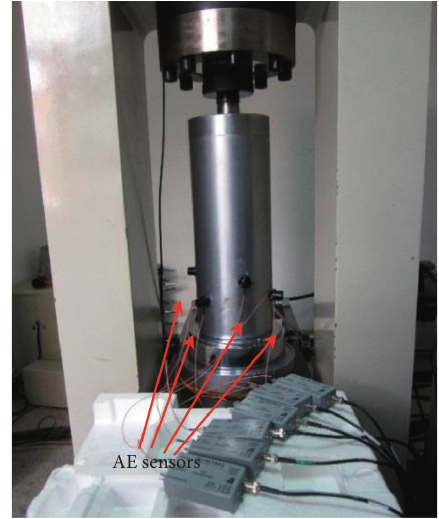
Figure 2: Triaxial compressive test of granite with AE